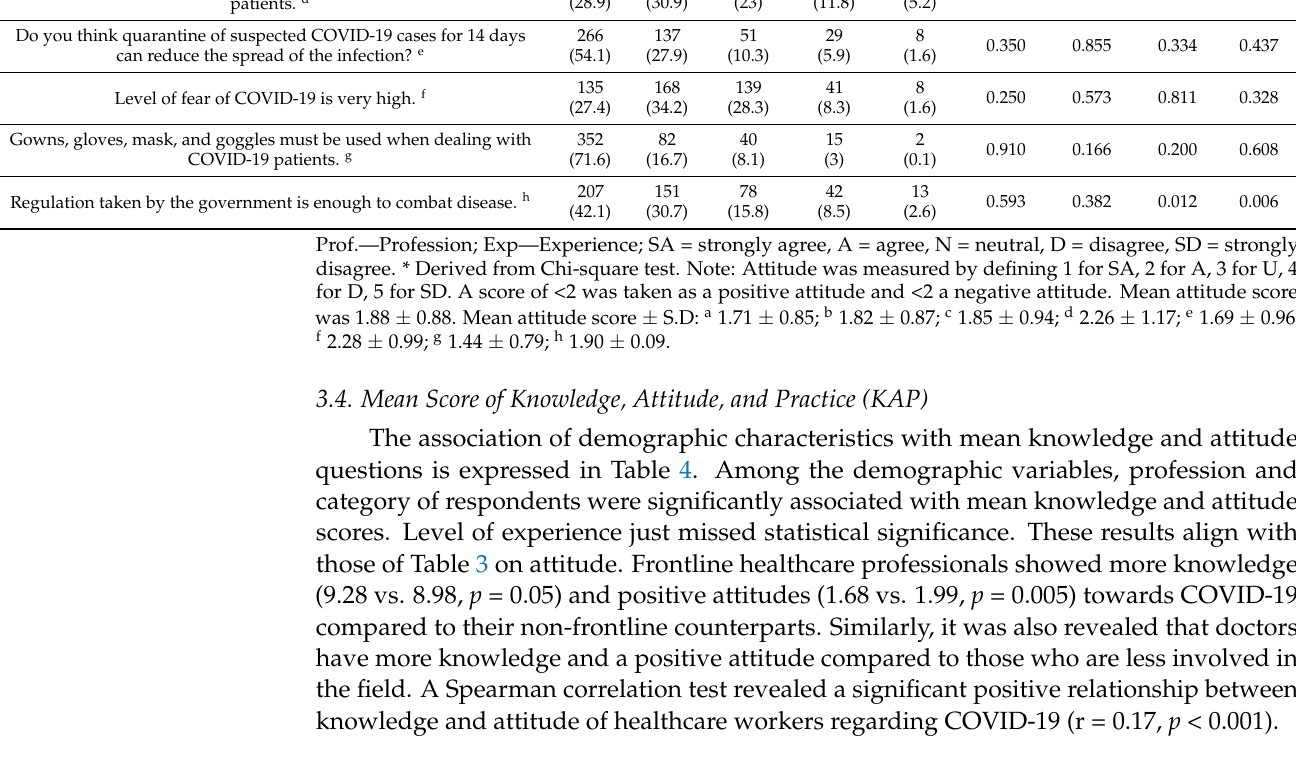
Table 4. Mean score of knowledge, attitude, and practice